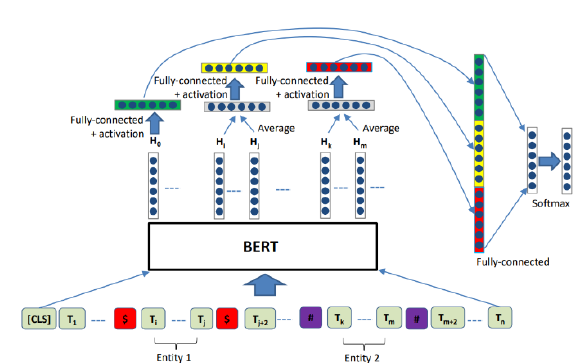
Figure 4 . The structure of R-BERT model (Wu et al.,